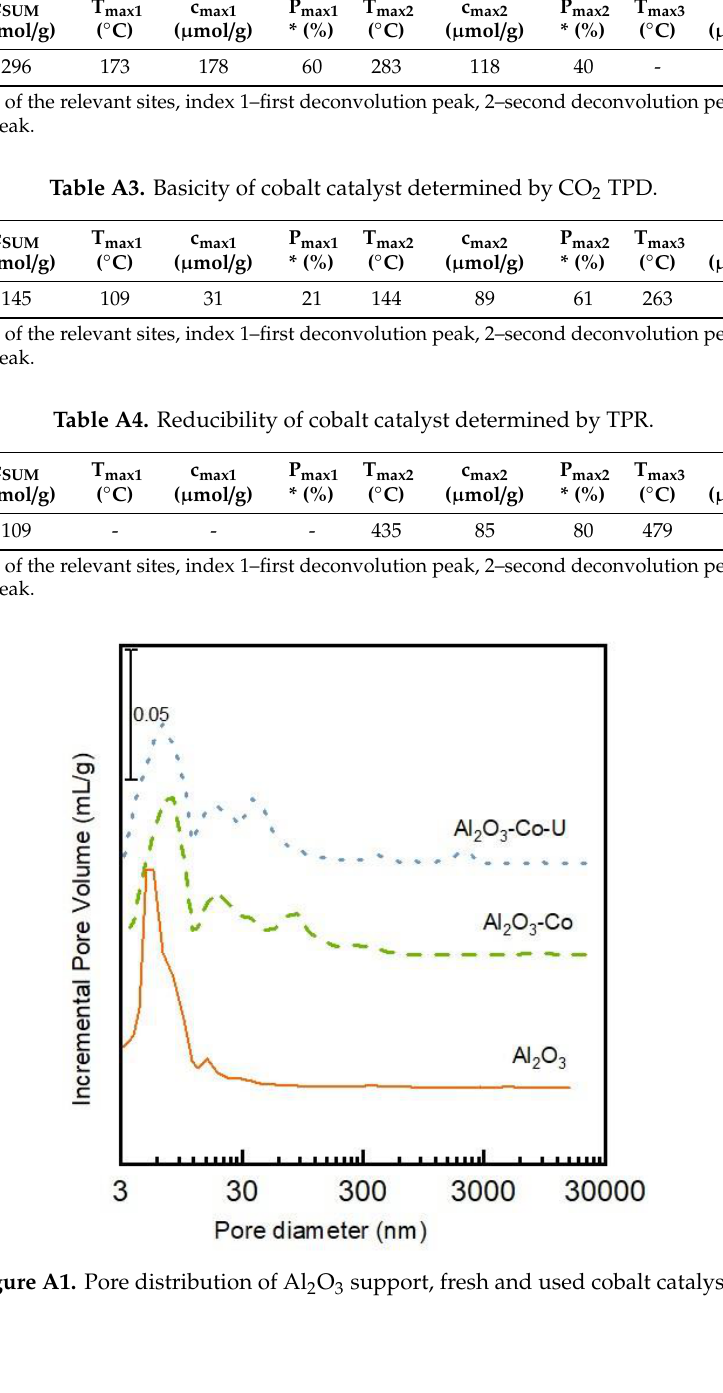
Table A2. Acidity of cobalt catalyst determined by ammonia TPD.